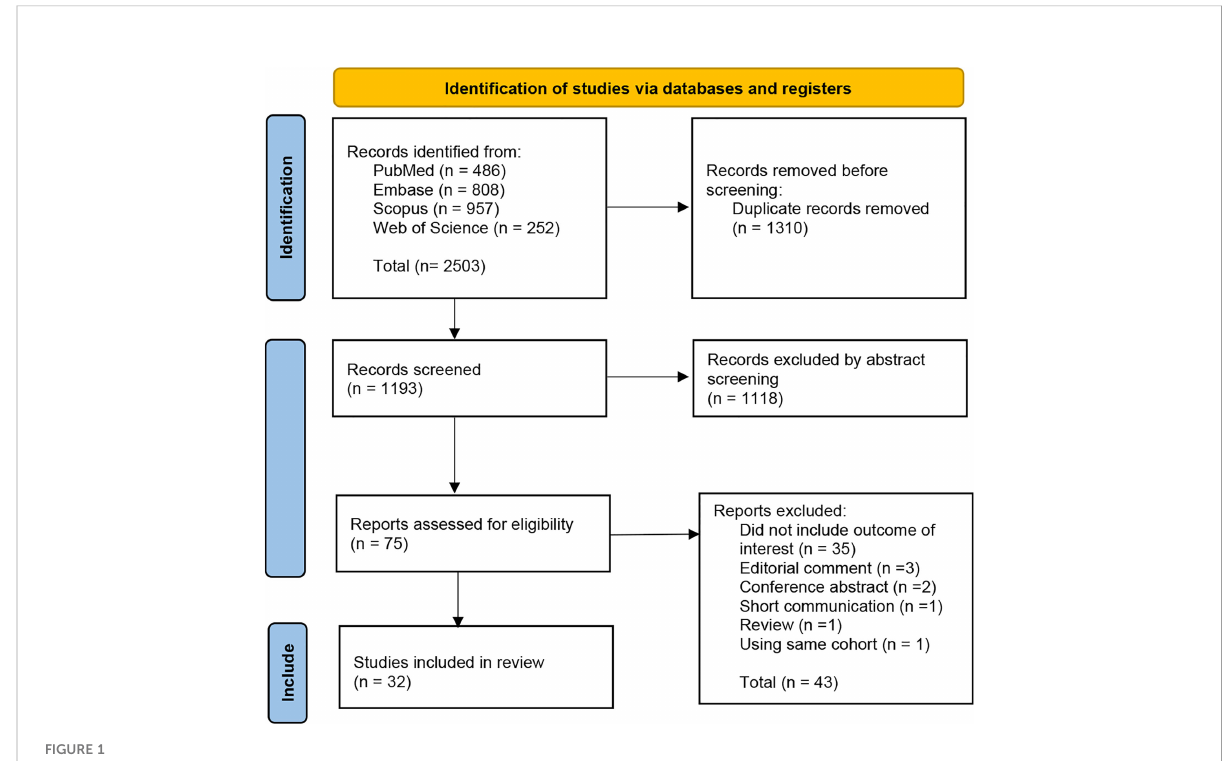
FIGURE 1 Prisma fl ow